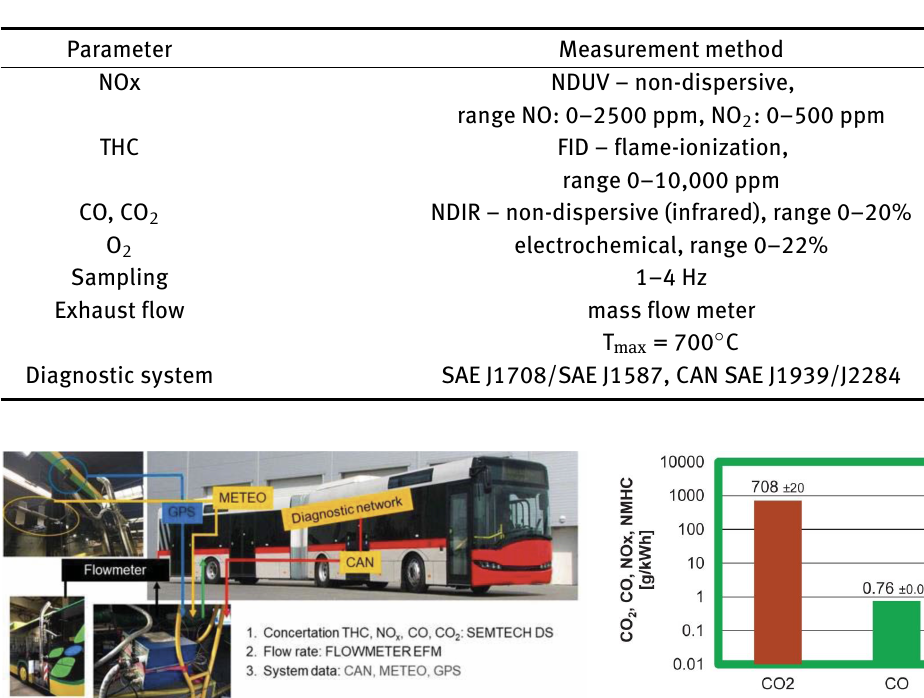
Table 4: Measurement parameters of the mobile exhaust measuring system [21].